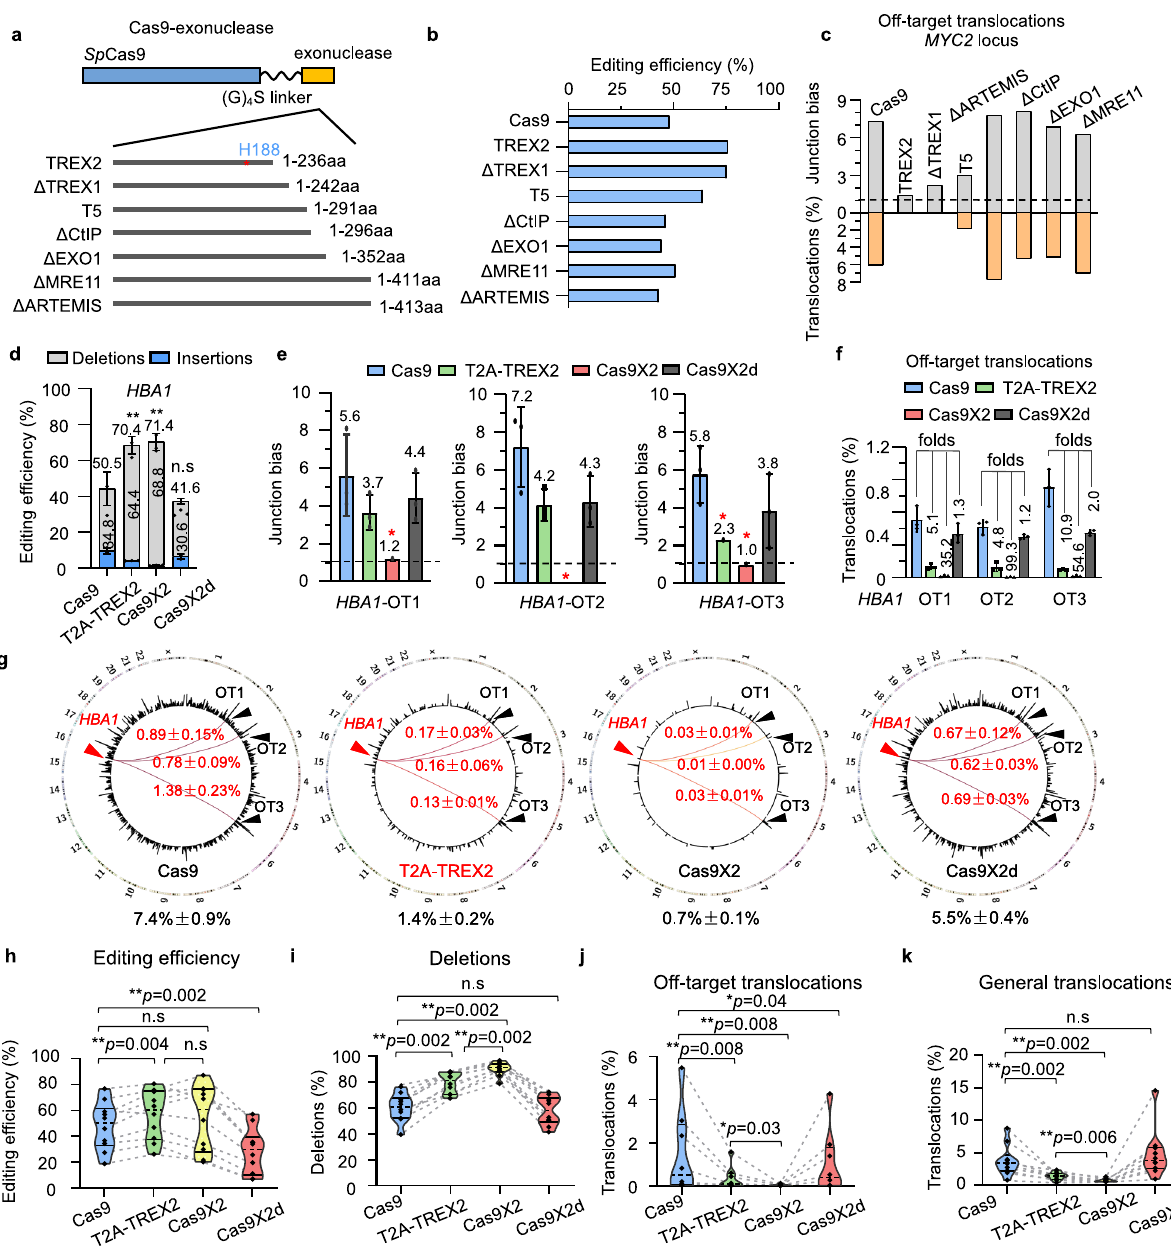
Fig. 3 Reducing repeated cleavage and chromosomal translocation with a Cas9 exo-endonuclease. a Schematic for tested Cas9-exonuclease fusion proteins. H188 is indicated. Δ represents truncated. b, c Editing ef fi ciency ( b ), junction bias ( c ) at off-target site and percentages for off-target translocations for indicated Cas9-exonucleases in HEK293T cells detected by PEM-seq, N = 1. d Editing ef fi ciency for Sp Cas9, Cas9X2, T2A-TREX2, and Cas9X2d at the HBA1 locus in HEK293T cells detected by PEM-seq. Gray bars represent the ratios of deletion, and blue bars represent the ratios of insertion. The deletion ratio and total editing ef fi ciency are marked on each bar. Mean ± SD from three biological replicates, paired two-tailed t -test, ** p < 0.01, n.s means no signi fi cance. e , f Junction bias ( e ) and off-target translocation ratios ( f ) for Sp Cas9, Cas9X2, T2A-TREX2, and Cas9X2d at HBA1 in HEK293T cells detected by PEM-seq. The junction bias and fold changes of off-target translocations are at the top of each bar, mean ± SD from three biological replicates. g Circos plot for translocations of Sp Cas9, Cas9X2, T2A-TREX2, and Cas9X2d PEM-seq libraries at HBA1 in HEK293T cells. Red arrows indicate on-targets and black arrows indicate identi fi ed off-targets. The percentages of off-target translocations are marked in red and the percentages of general translocations are marked in black, mean ± SD from three biological replicates. h – k Editing ef fi ciency ( h ), deletions ratios in editing events ( i ), percentages of off-target translocations ( j ), and percentages of general translocations ( k ) for Sp Cas9, Cas9X2, T2A-TREX2, and Cas9X2d PEM- seq libraries in HEK293T cells, one PEM-seq library for each locus, N = 10. The loci used were DNMT1-1 , DNMT1-2 , EMX1 , HBA1 , C-MYC1 , C-MYC2 , C-MYC3 , RAG1A , RAG1B , and RAG1C . Note that off-target translocations were not detected in several loci for Cas9X2. Two-tailed Wilcoxon test, * p < 0.05, ** p < 0.01, n.s means no signi fi cance. Source data are provided as a Source Data fi le.